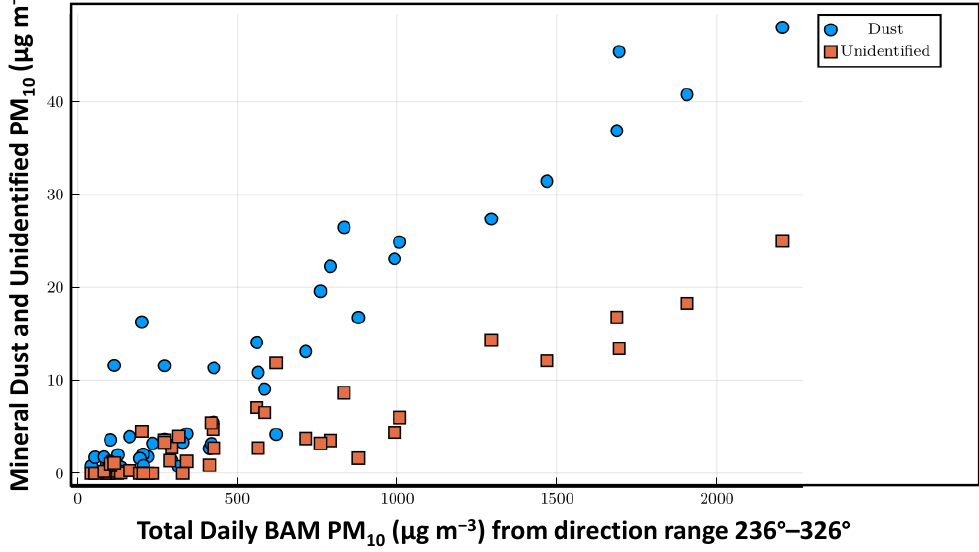
Figure 15. The relation between the MD and unidentified components of the PM 10 and the total daily PM 10 calculated from the BAM for all the valid sampling days from April to October 2021.